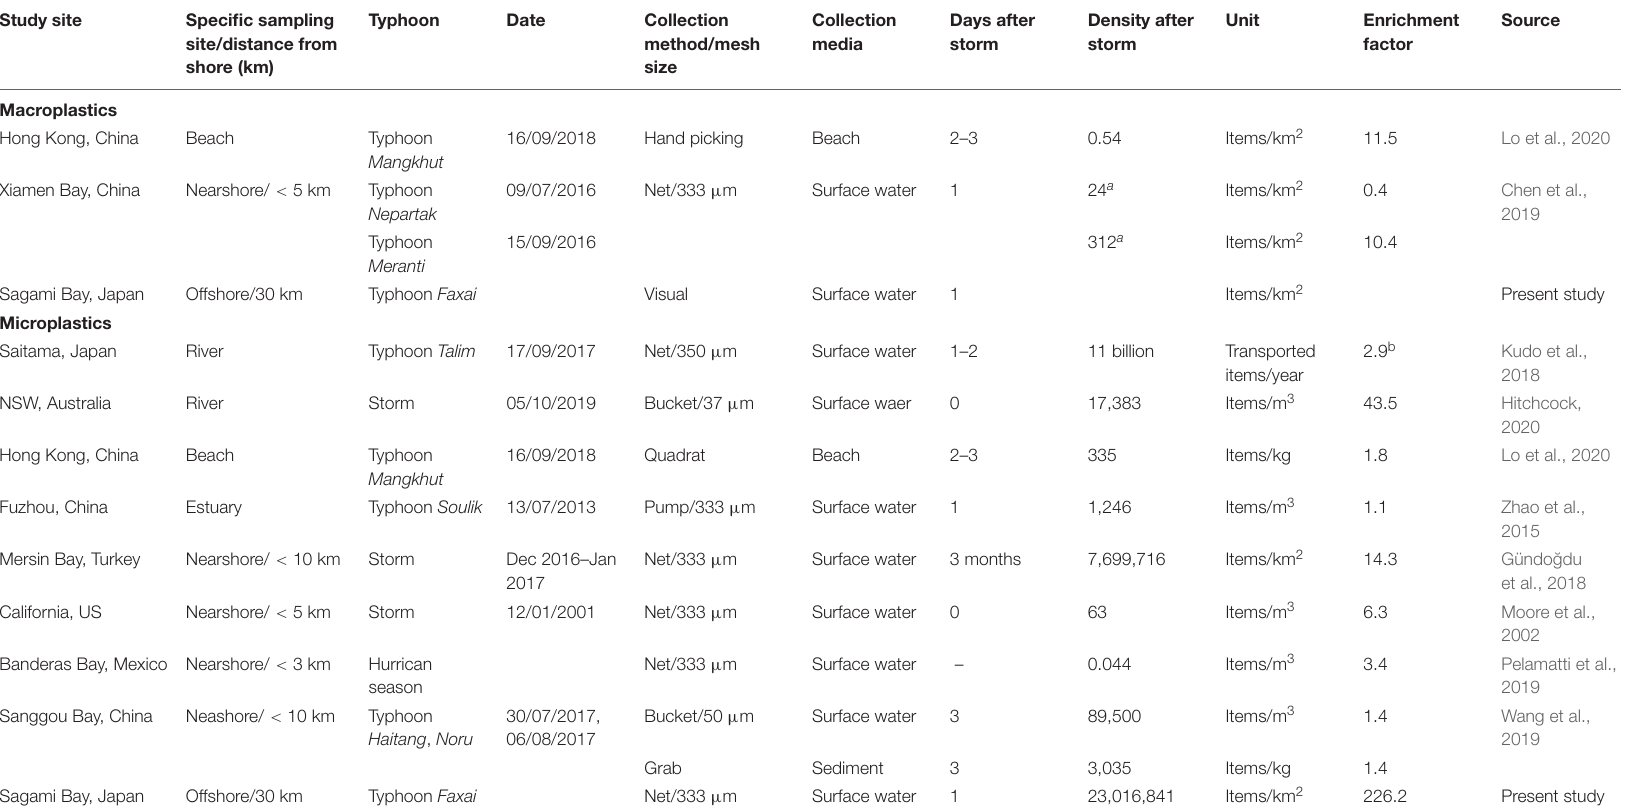
TABLE 1 | Comparative summary of the enrichment factors of macro- and microplastics in several bodies of water after storm